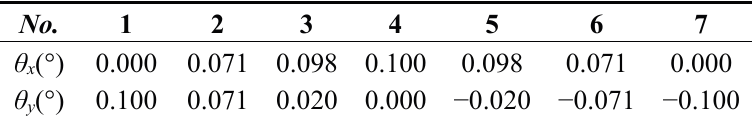
Table 1. Variations of the field of view for the system along seven directions. Variations No. 1 and 7 are selected along the y directions, No. 5 along the x direction, No. 2 and 6 along the diagonal directions, and No. 3 and 5 are selected according to the aspect factor by the field of view of the system in y and x directions.